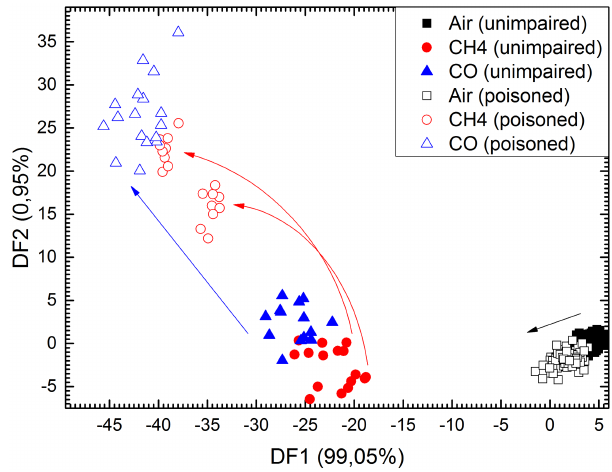
Figure 9. LDA of 10 EIS features (mean values/slopes) for the unimpaired (solid symbols) and the poisoned (open symbols) sen- sor, acquired with FoBIS impedance